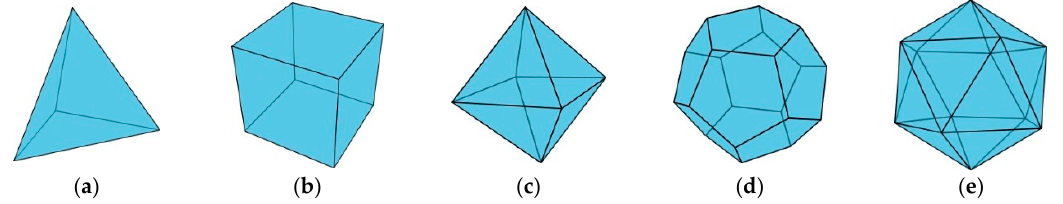
Figure 1. Five base polyhedrons for Discrete Global Grid Systems (DGGSs): ( a ) tetrahedron; ( b ) cube; ( c ) octahedron; ( d ) dodecahedron; ( e ) icosahedron (Source—cited from [8]).